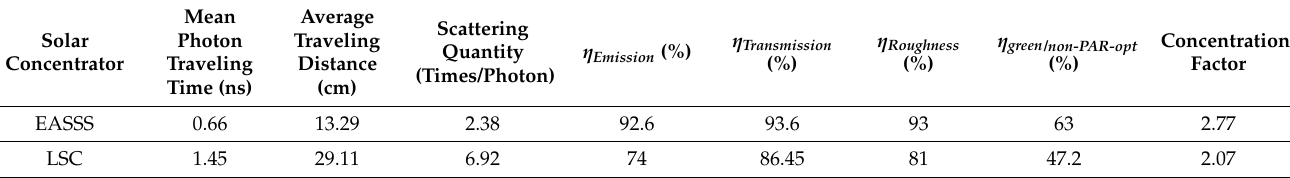
Table 1. Performance parameters for the EASSS and conventional planar LSC